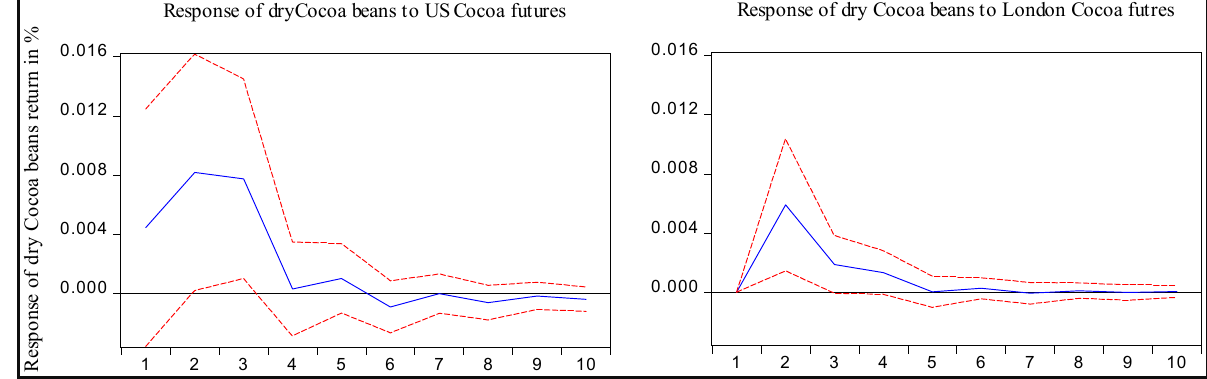
Figure 5. Impulse response of dry Cocoa beans returns to ICE traded Cocoa futures. The red line is 95% confidence interval and the blue line is the response to shock.